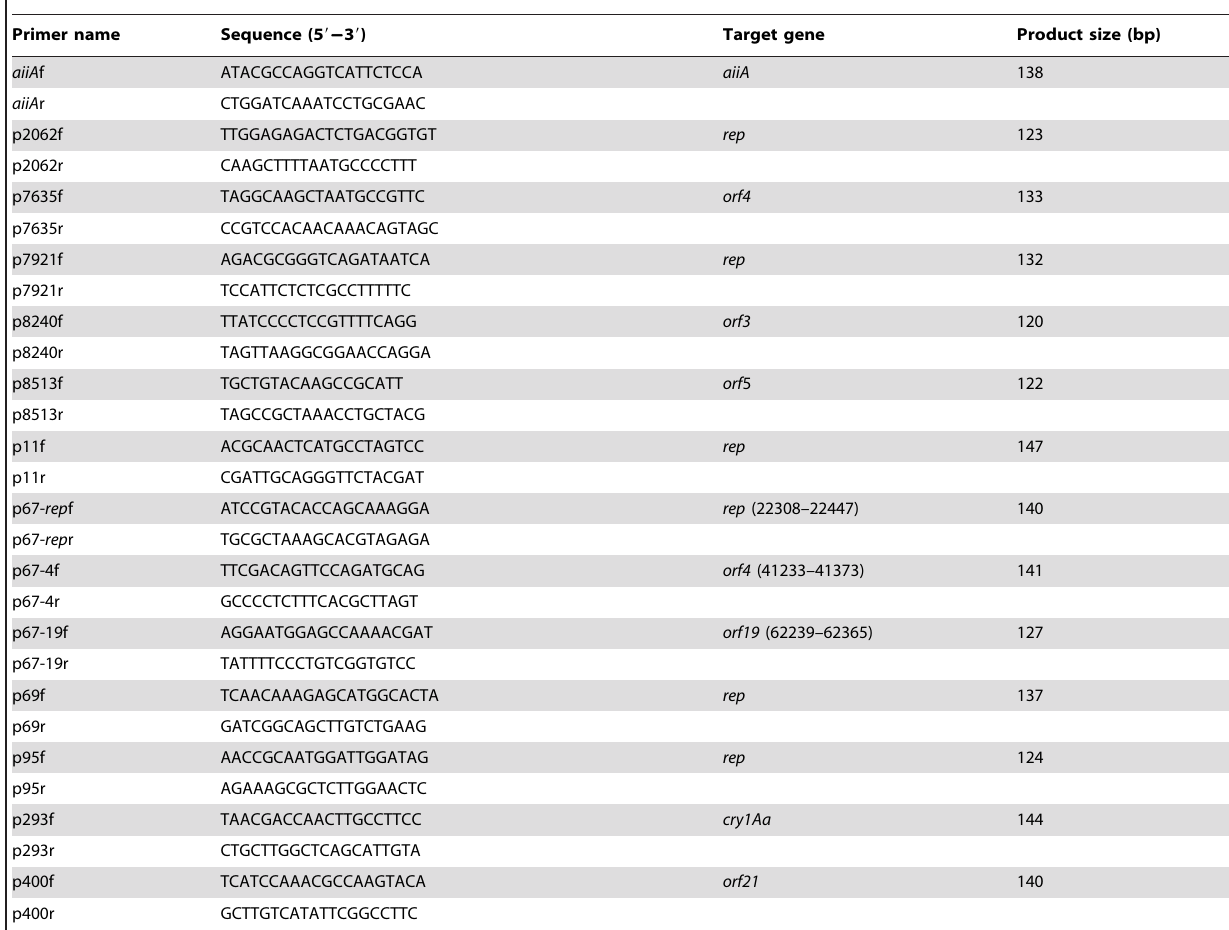
Table 4. Primers used in this